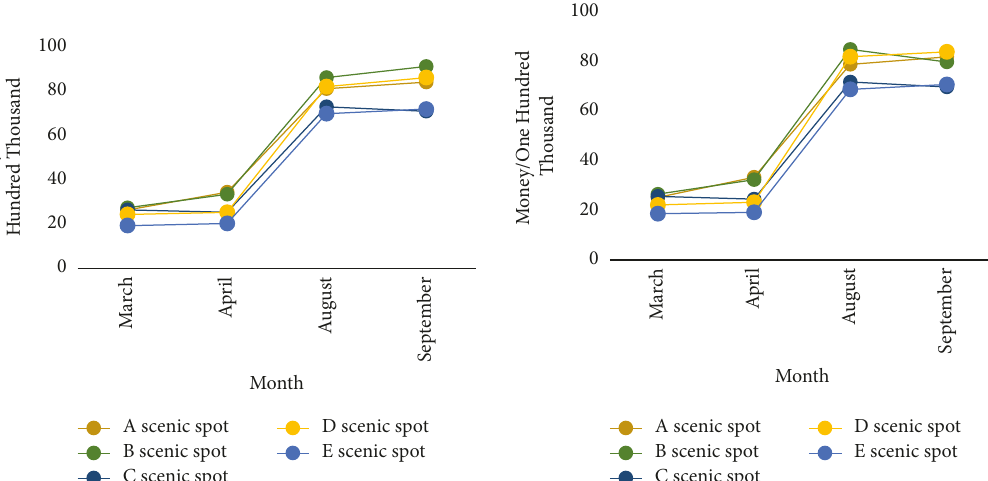
Figure 7: Scenic spot revenue impact.